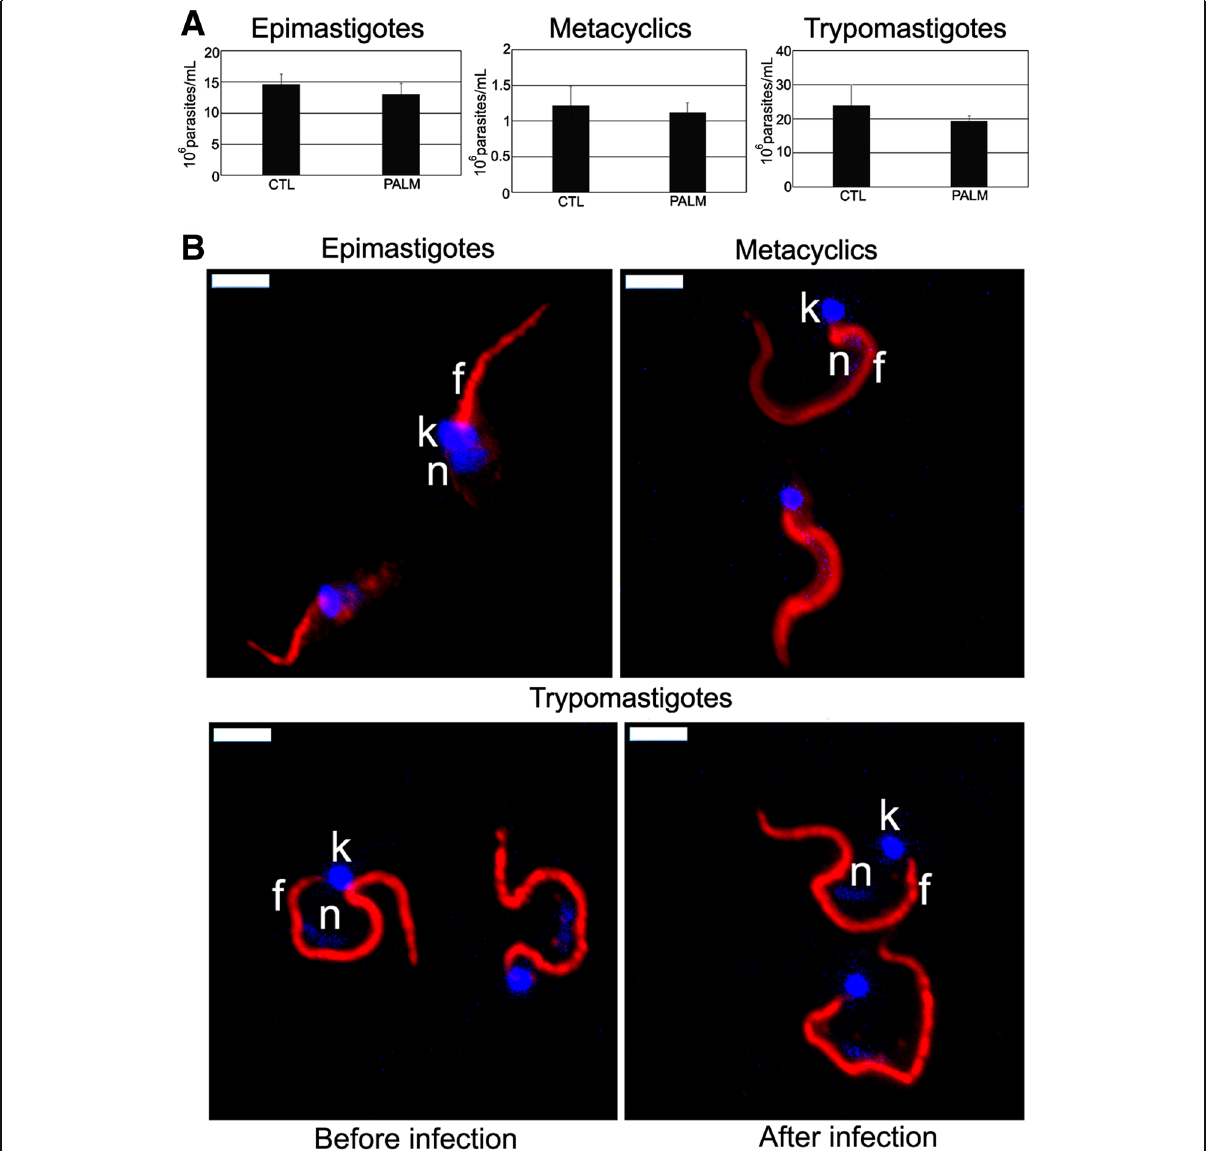
Fig. 10 Effect of palmitate on Trypanosoma cruzi . Different developmental forms were incubated with palmitate, using the respective IC 50 values of 2-BP. a No effect was observed on epimastigotes growth, metacyclics viability and cell-derived trypomastigotes infectivity. b Localization of TcFCaBP was not altered in all developmental forms tested. n: nucleus; k: kinetoplast; f: flagellum. Bars = 5 μ